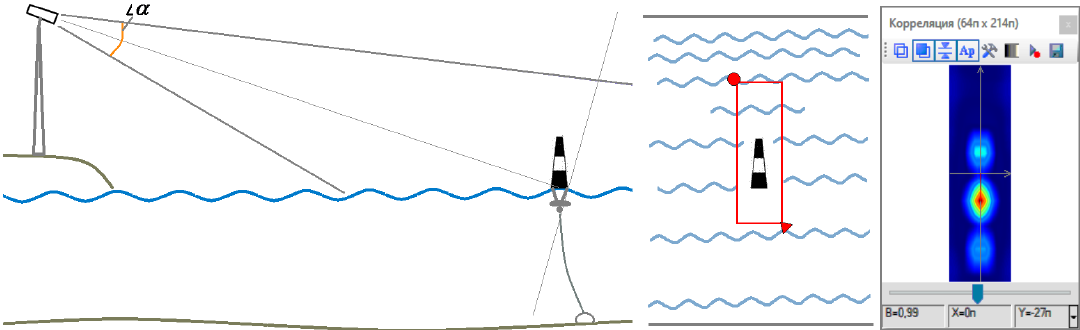
Figure 8. Measurement of the wave signal h ( t ): the observation scheme of the marker object and the measurement scheme, based on video analysis.